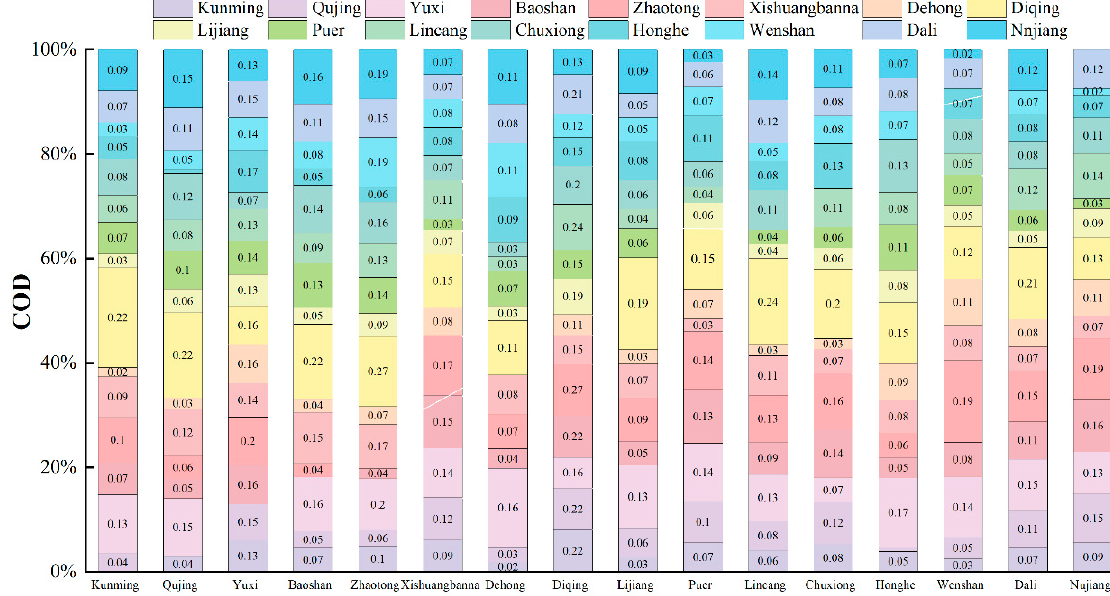
Figure 4. The COD values of O 3 -8h in Yunnan Plateau from 2015–2020.